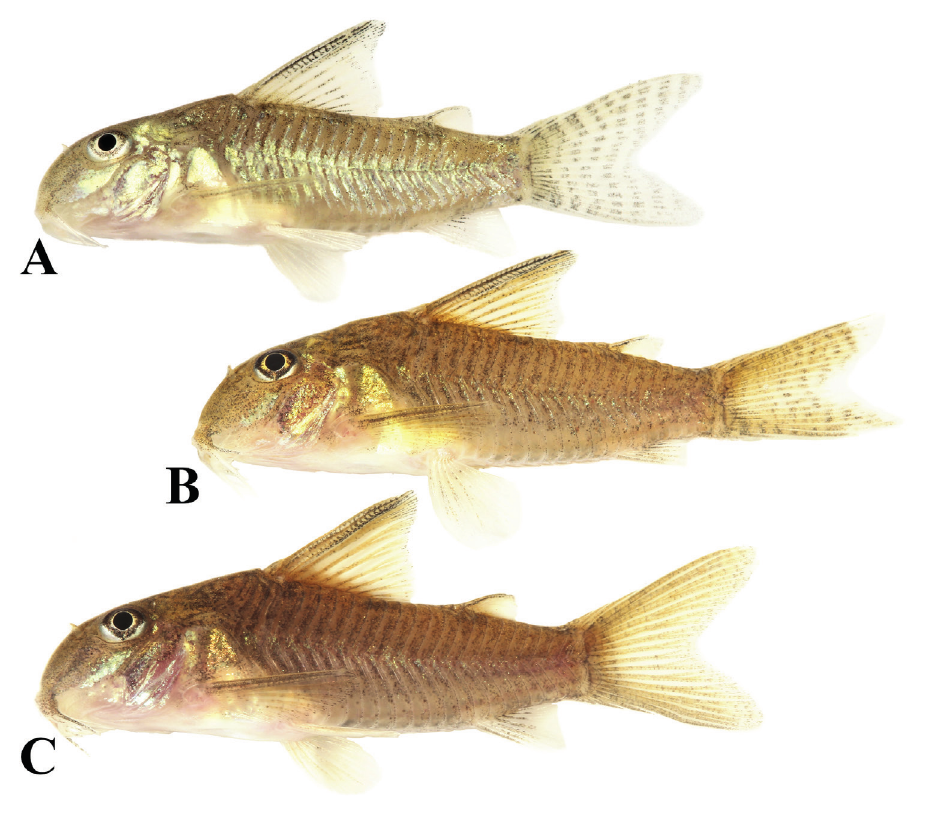
FIGURE 13 | Paratypes of Corydoras psamathos photographed alive, showing general color pattern and morphology in lateral view in ( A ) INPA 59772, 23.7 mm SL, ( B ) INPA 59773, 30.2 mm SL, and ( C ) INPA 59773, 29.3 mm SL. Specimen ( A ) is from the rio Jamanxim, and specimens ( B–C ) are from the igarapé Santa Júlia, rio Tapajós